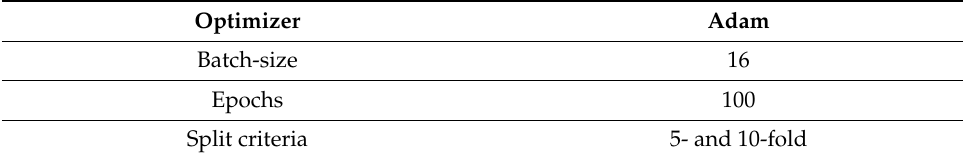
Table 2. Training parameters of the proposed model.